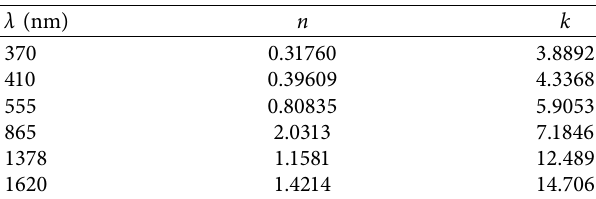
Table 2: Real and imaginary parts of complex refractive index for aluminum mirrors.